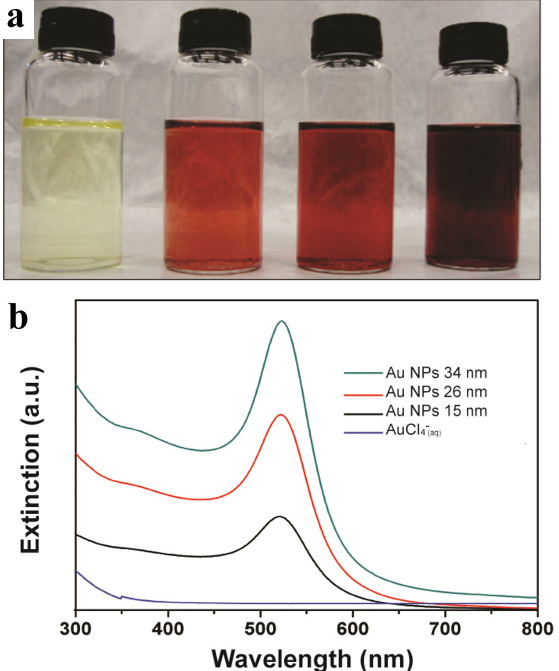
solution Figure 1 - a) Digital photographs of the AuCl 4- (aq) and aqueous suspensions containing Au NPs 15 ± 2.2, 26 ± 2.4, and 34 ± 3.0 nm in diameter (shown from left to right, respectively). b) UV-VIS extinction spectra recorded for the AuCl 4- solution and aqueous suspensions containing Au NPs (aq) 15 ± 2.2, 26 ± 2.4, and 34 ± 3.0 nm in diameter (blue, black, red, and green traces, respectively). Adapted with permission from ref. (da Silva et al . 2014) Copyright 2014 Scielo